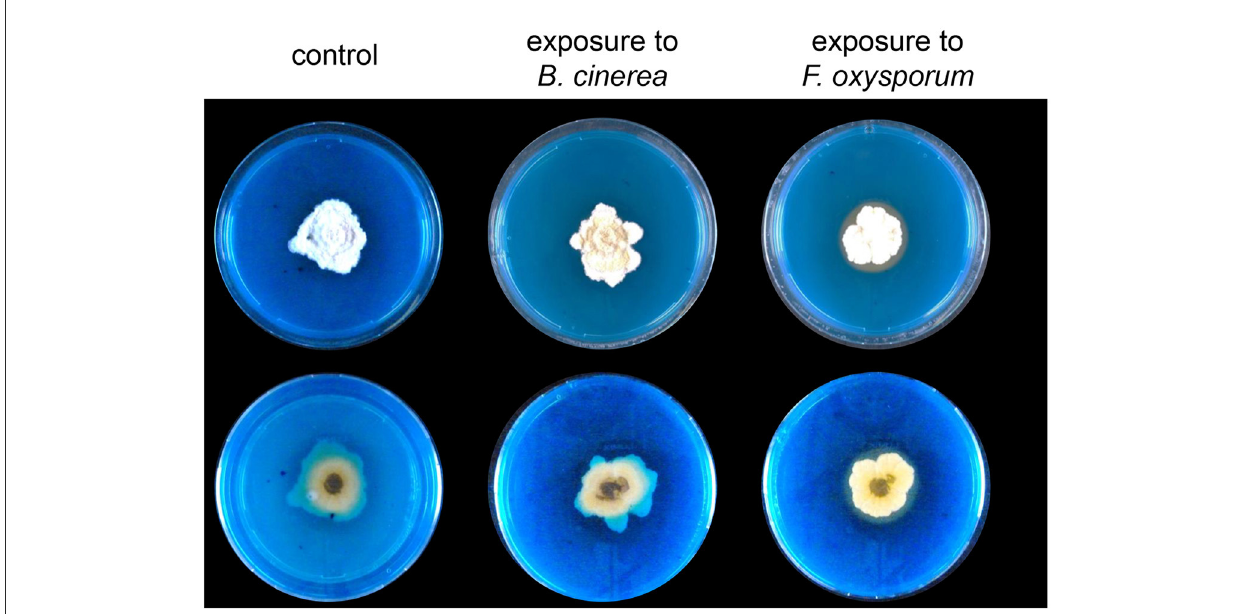
FIGURE6 Representative pictures of (top) and (bottom) views of Trichoderma grown on CAS medium and exposed to Botrytis or Fusarium volatiles for 2 weeks in a sandwich plate assay ( n = 4). The orange color shows the presence of siderophores secreted by Trichoderma. Control plates were exposed to